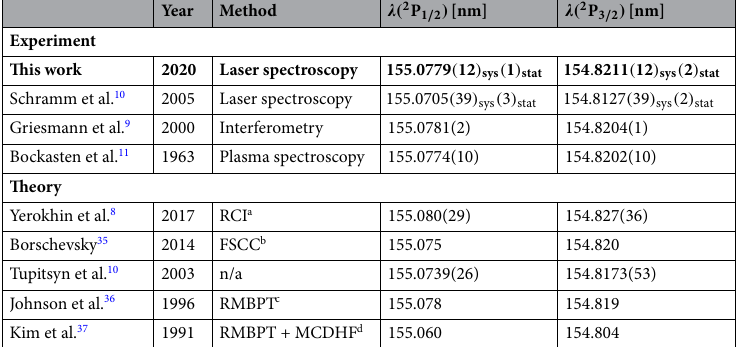
2 S 2 P 2 S 2 P 1 / 2 − 1 / 2 and 1 / 2 − 3 / 2 transitions